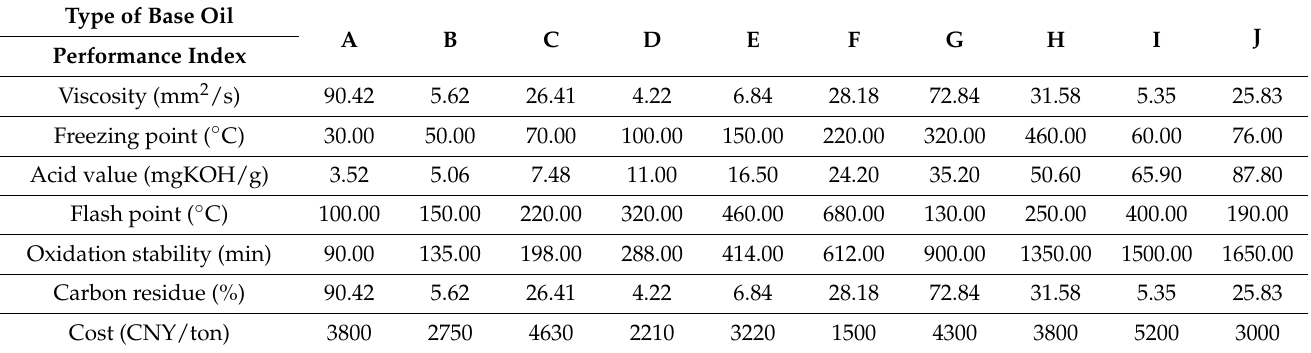
Table 1. Performance indexes and costs of base oils.